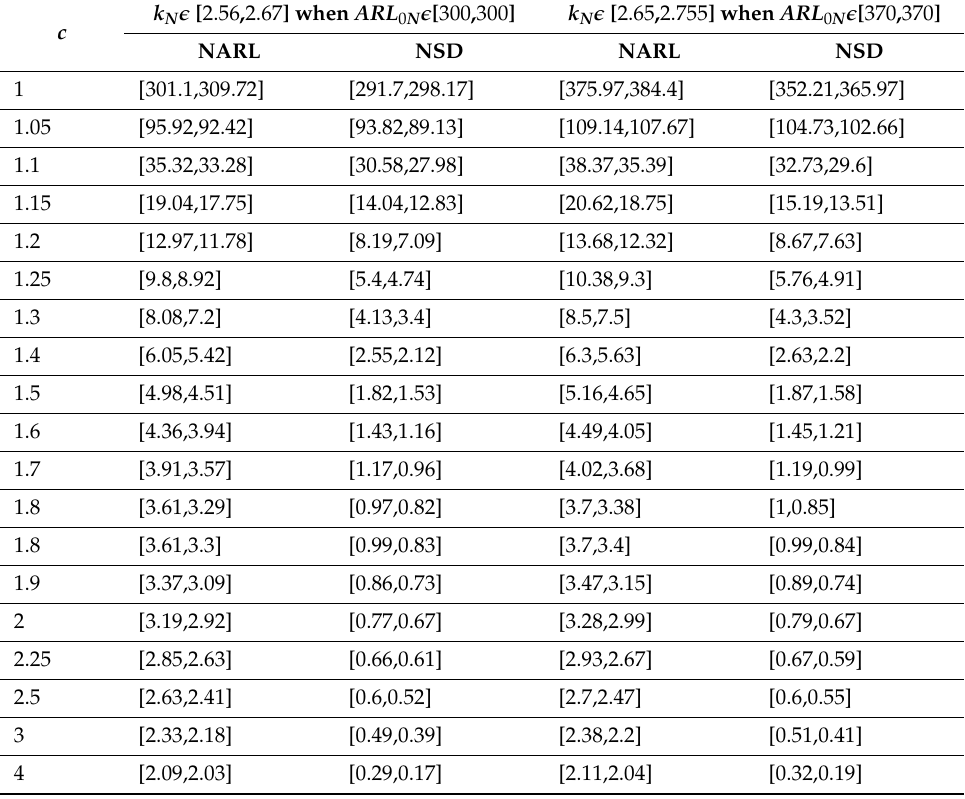
Table 5. The neutrosophic average run length (NARL) when n N (cid:15) [8, 10] and λ N (cid:15) [0.08, 0.12]. c